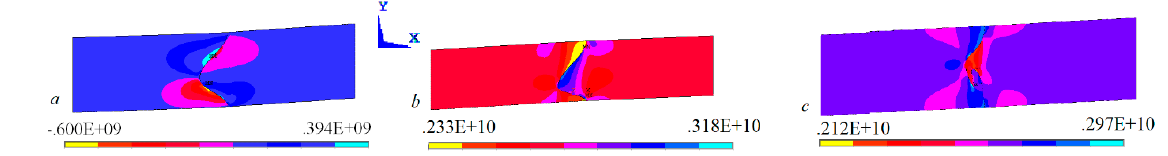
Figure 5. The local von Mises stresses corresponding to the shift for ( a ) symmetric wave, ( b ) asymmetric wave, ( c ) wave with с rest, Figure 3 с .